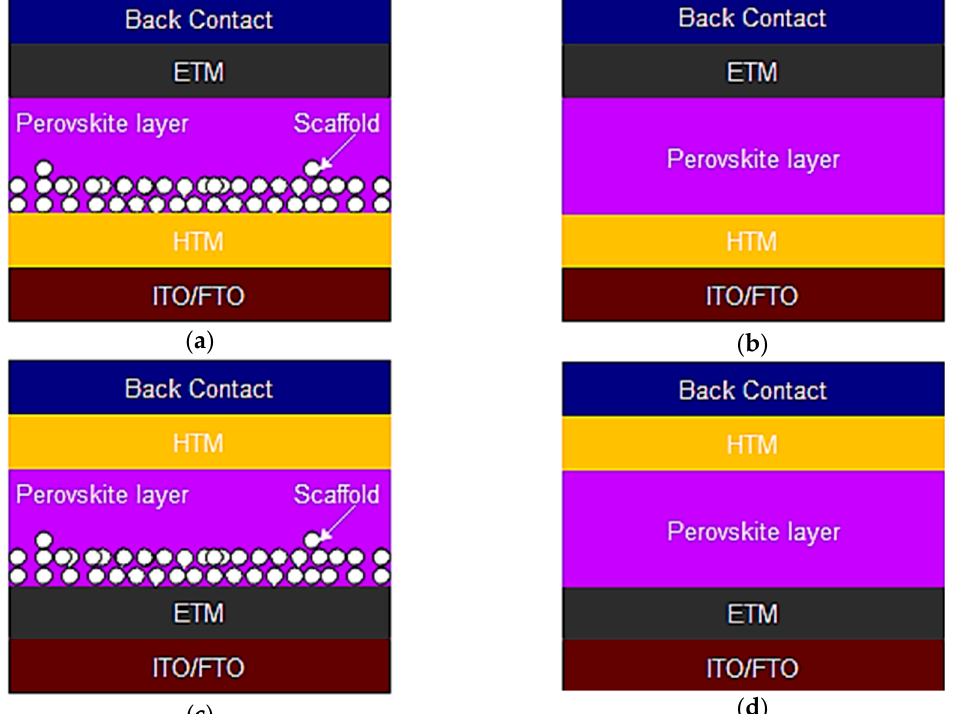
Figure 1. Different PSC device architecture ( a ) Inverted mesoscopic (p-i-n) device ( b ) Inverted planar (p-i-n) device ( c ) Mesoscopic (n-i-p) device ( d ) Planar (n-i-p) device. The first solid-state PSC was introduced by Kim et al.